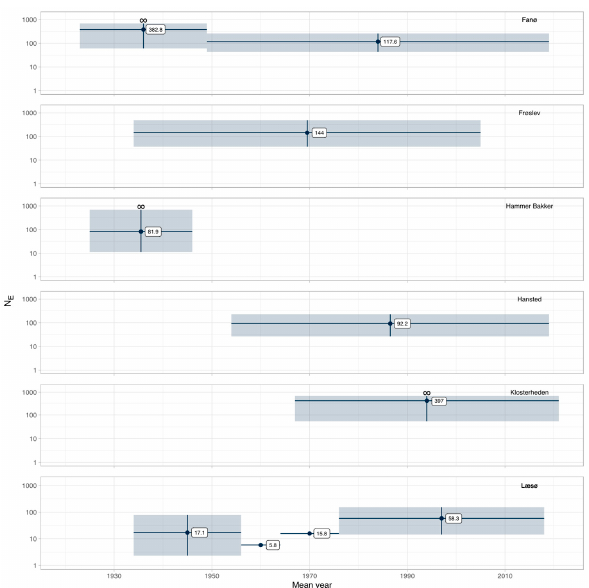
Figure 9. Estimates of effective population sizes in six populations. Vertical whiskers show 95% confidence intervals where infinite upper limits are labeled with “ ∞ ”. Points and lateral whiskers show the mean and range of the pair of years used for the estimate. The species is extinct at both Hammer Bakker and Frøslev Mose.